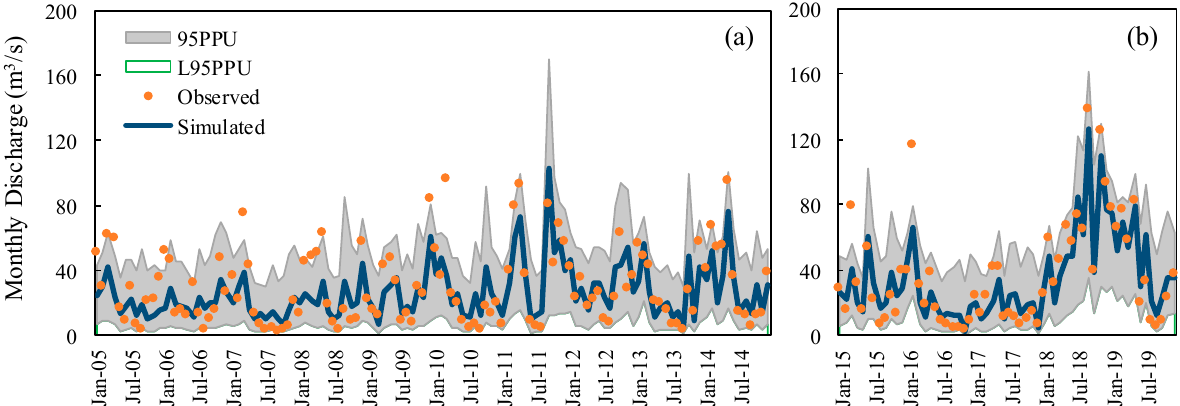
Figure 3. The hydrograph of average monthly observed and simulated discharge during ( a ) calibration (2005–2014) and ( b ) validation (2015–2019).